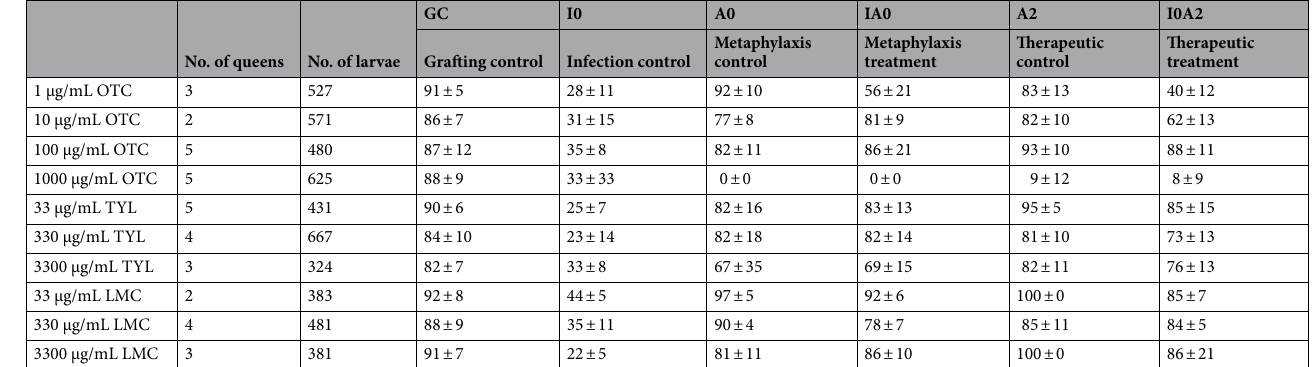
Table 2. Summary o f larval rearing experiments showing survival a 6 days after grafting and treatment. a Survival is expressed as mean percent ± standard deviation between